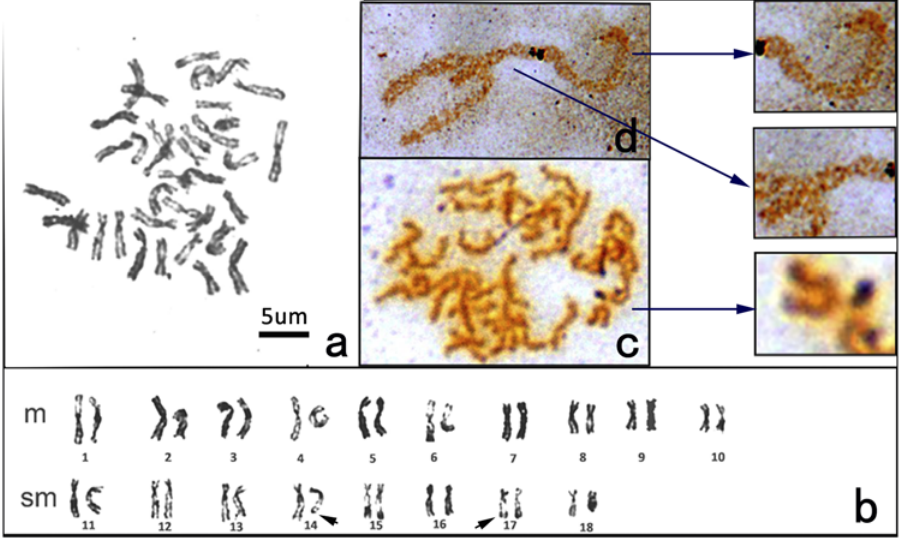
Fig 1. Karyotypes and NOR-bearing chromosomes of H. discus hannai . a: Digital image of metaphase plate from larvae of H. discus hannai . b: Karyotype of H. discus hannai . c: A metaphase of H. discus hannai with a short arm terminally NOR-bearing chromosome. d: A metacentric chromosome with short arm terminally NOR-bearing and a submetacentric chromosome with its short arm terminally NOR-bearing. (The arrows indicate zoom from chromosomes from parts c and